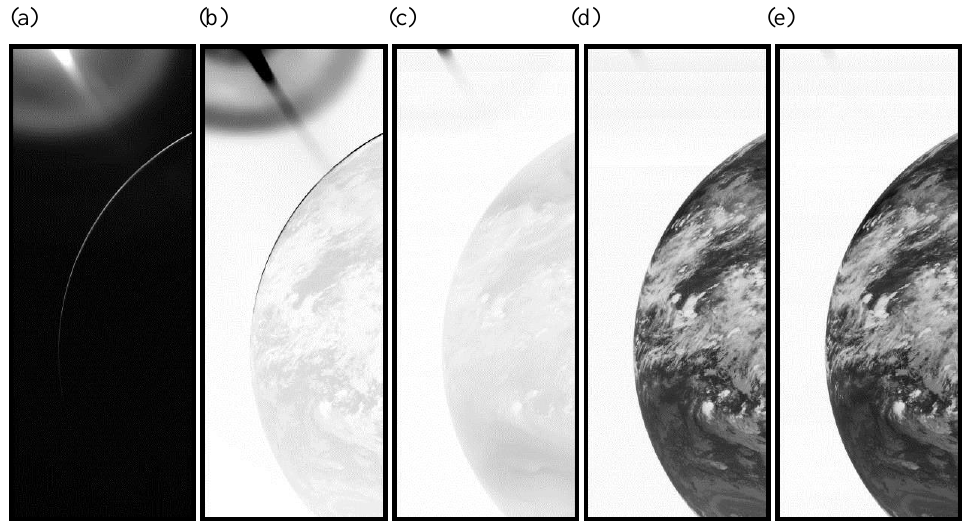
Figure A3. Effect of solar intrusion on the optical cavity of COMS/MI for different channels: (a) visible, (b) shortwave infrared, (c) water vapor, and the two infrared window channels (d) and (e) on 20 August 2010.